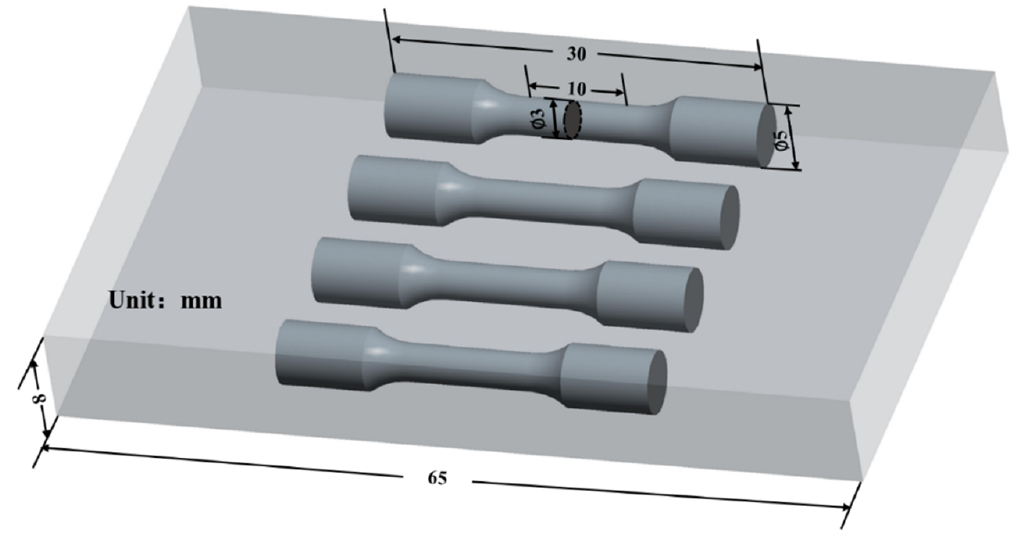
Figure 2. Machining drawing of the tensile specimens.